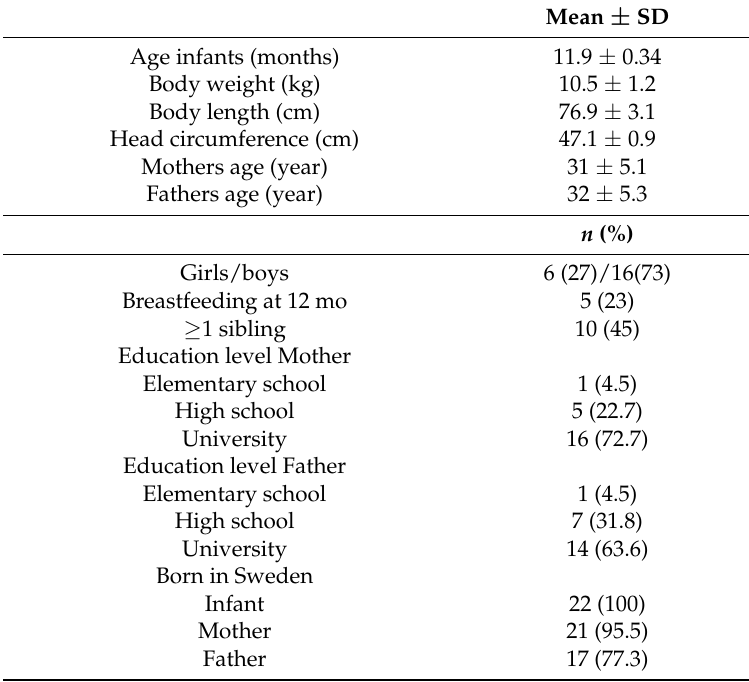
Table 1. Anthropometric and demographic data of the study infants ( n = 22) and their parents.